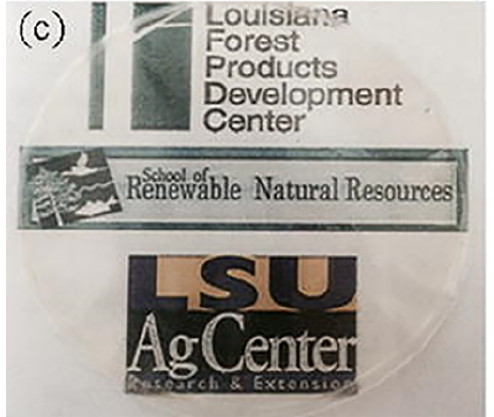
Figure 10: Digital Image of CNC nanopaper displaying high trans- parency. Modified from [31] with permission of Springer